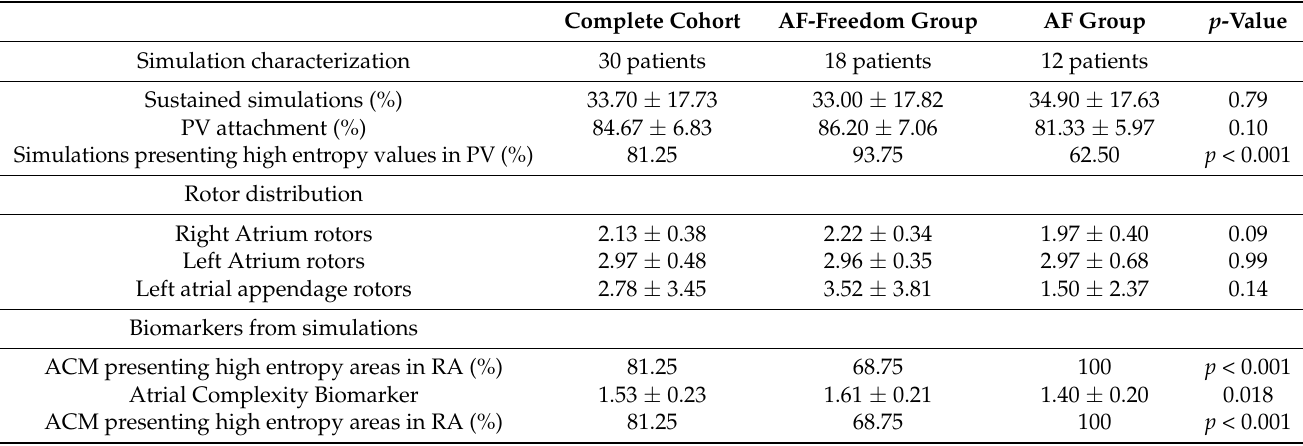
Table 2. Electrophysiological description of the